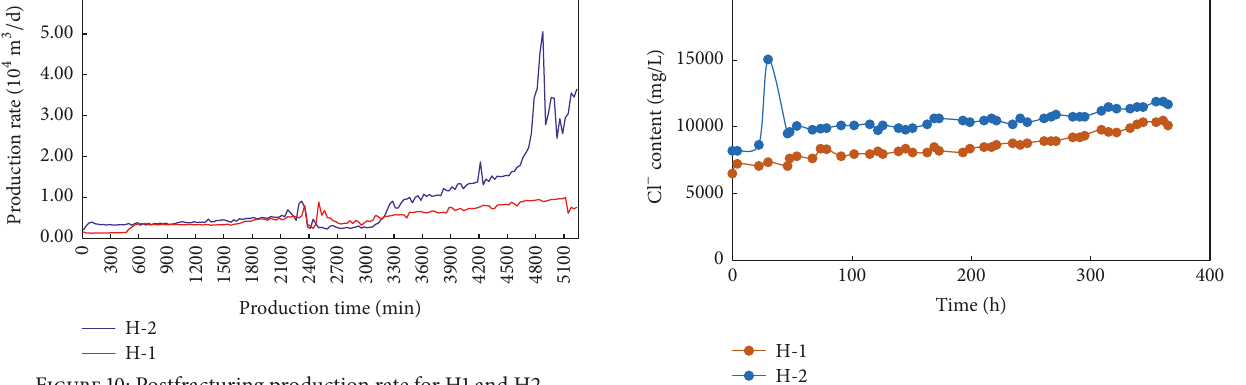
Figure 11: Postfracturing Cl − content levels in H1 and